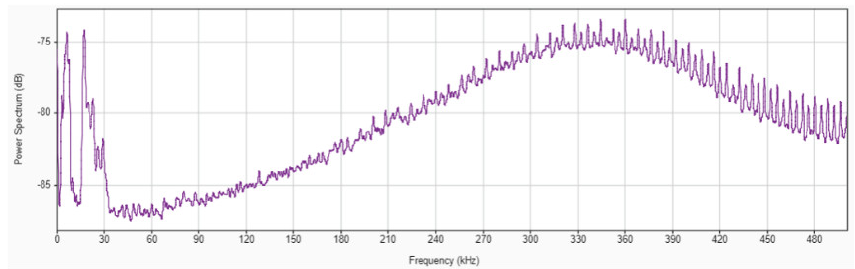
Figure 6. FFT of the AE signal during one grinding pass during Test No.2.